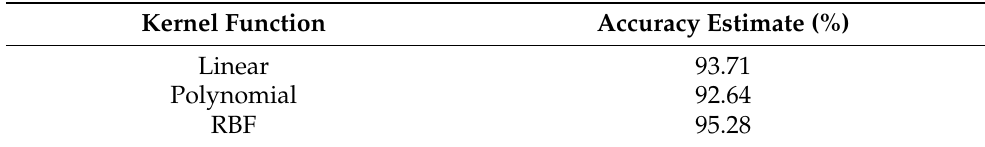
Table 1. Accuracy estimates of different kernel